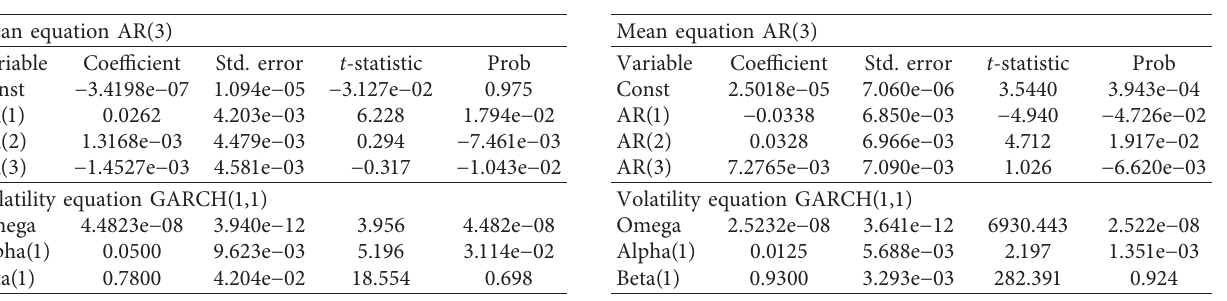
Table 6: The fitting results of the GARCH (1,1) model during the HFT restricted